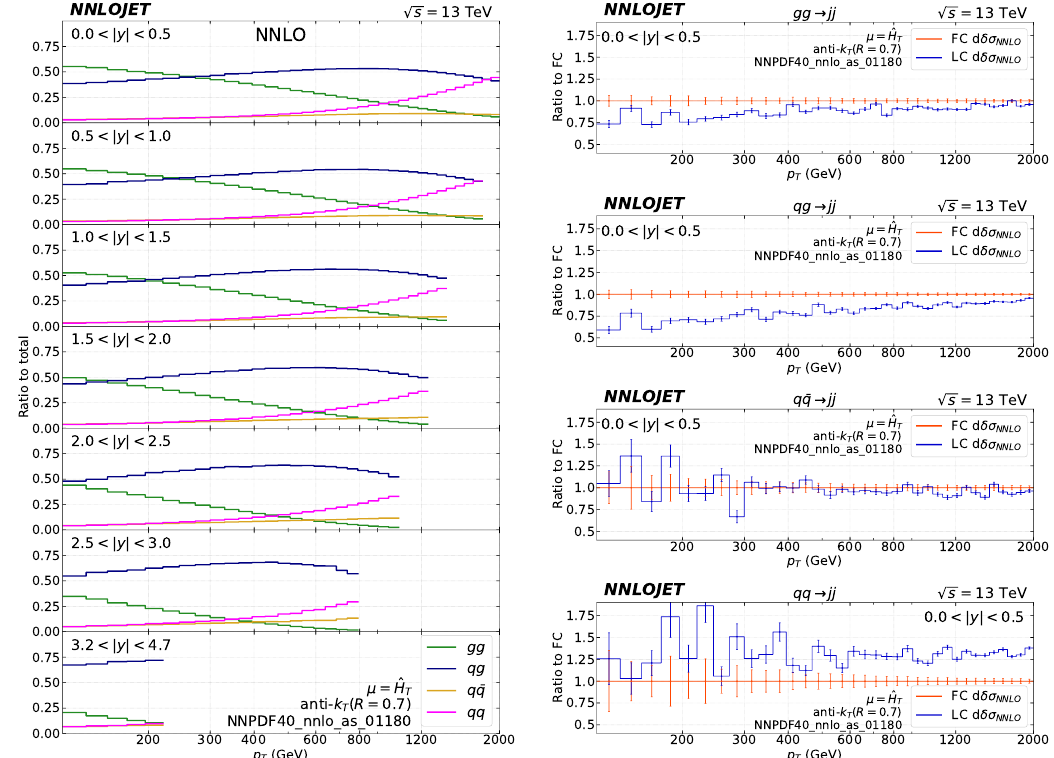
Figure 8 . Relative contribution of each parton-parton initial state to the total single jet inclusive cross section distributions at NNLO (left) and NNLO coefficient d δσ NNLO at LC (blue) and FC (red) predictions for (from top to bottom) the gluon-gluon, quark-gluon, quark-antiquark and quark- quark initiated R = 0 . 7 single jet inclusive cross section as function of p T for the central rapidity slice 0 < | y | < 0 . 5 , normalized to the FC prediction